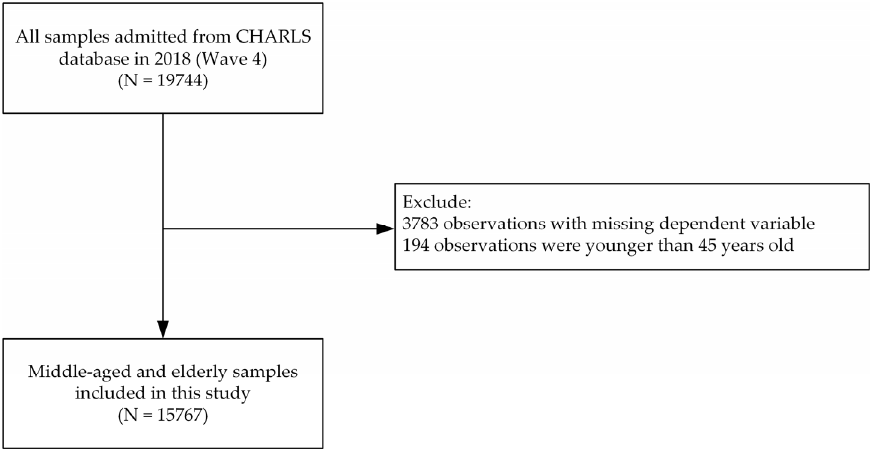
Figure 1. Selection of study participants. The N stands for the observations.